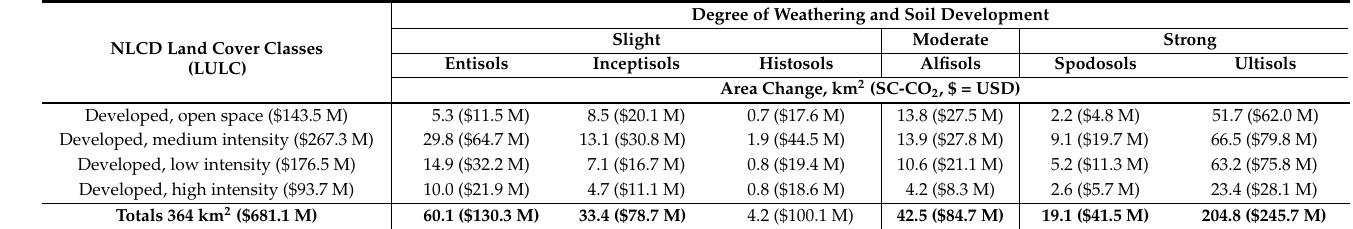
Table 10. Increases in developed land and maximum potential for realized social costs of carbon due to complete loss of total soil carbon (TSC) of developed land by soil order in New Jersey (USA) from 2001 to 2016.